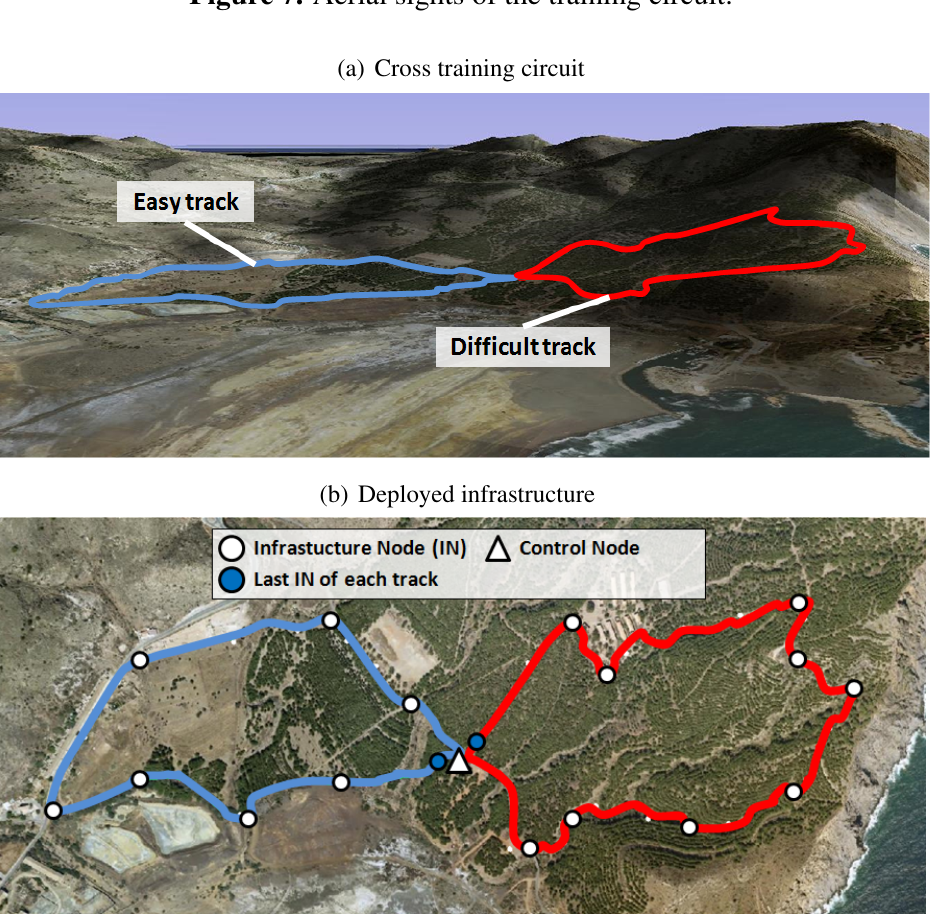
Figure 7. Aerial sights of the training circuit. (a) Cross training circuit